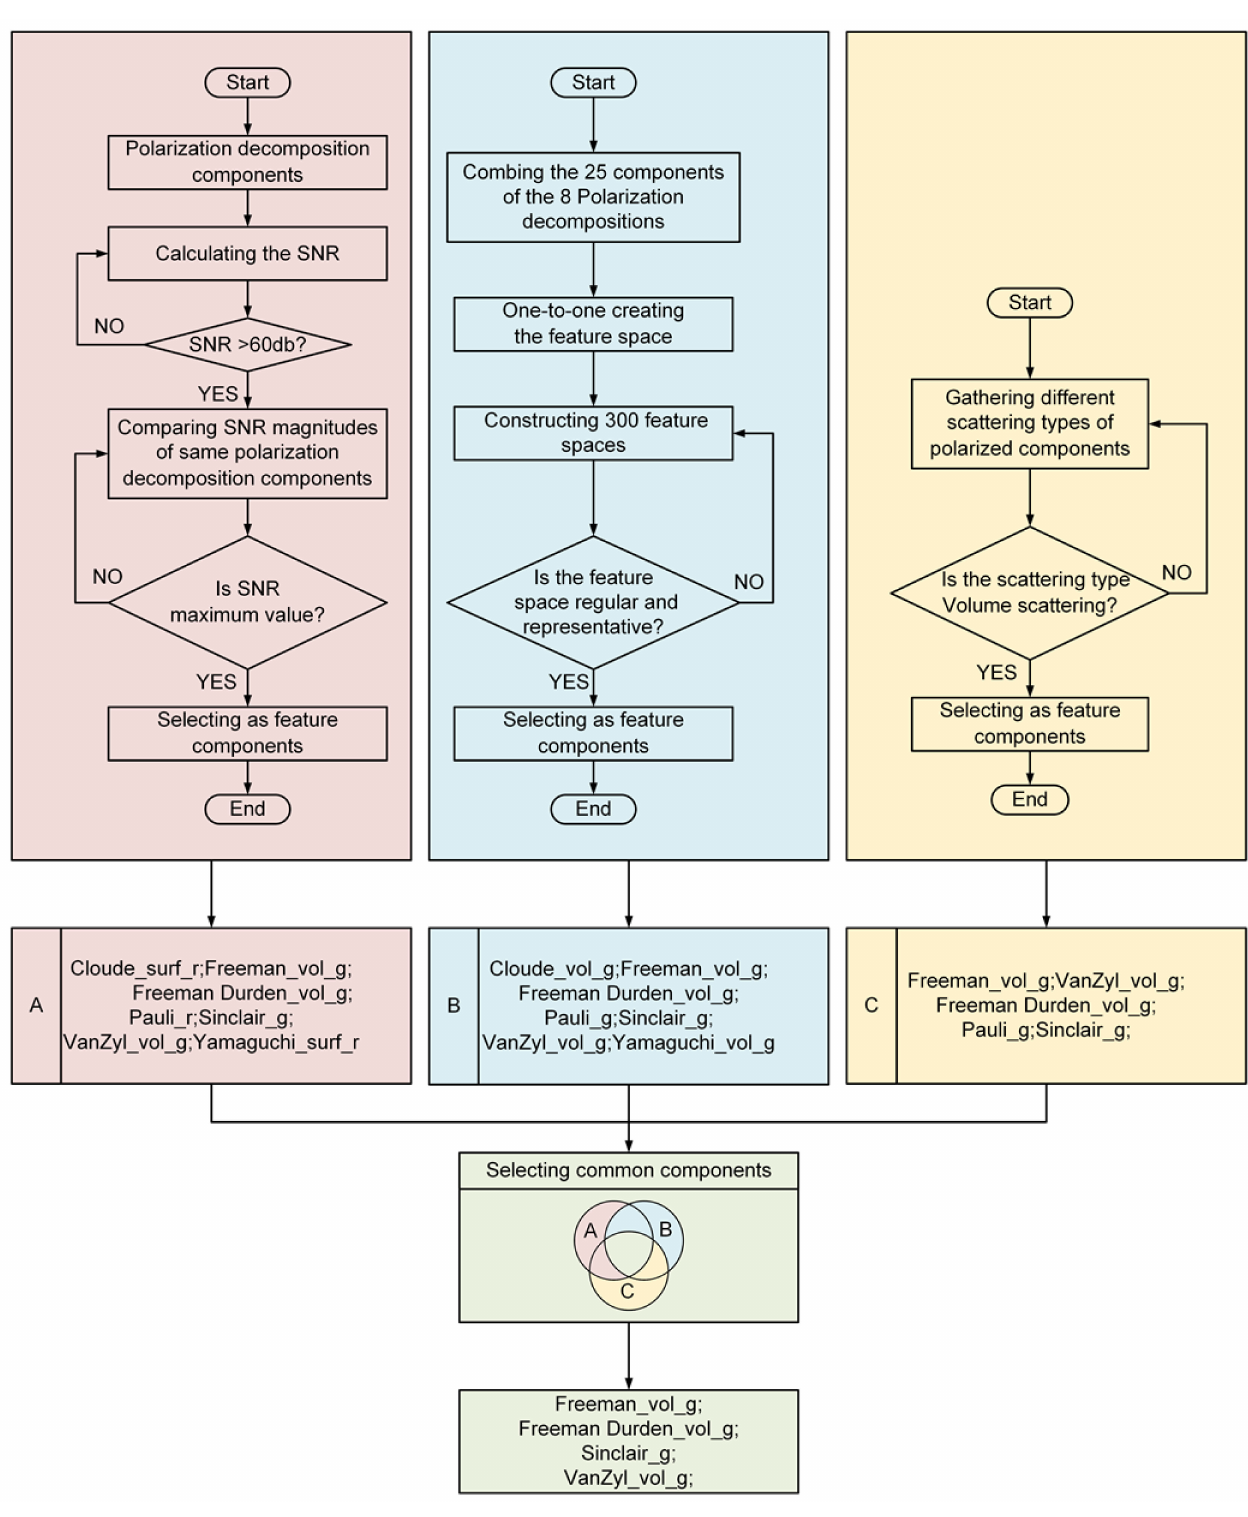
Figure 5. The overall workflow of the feature selection